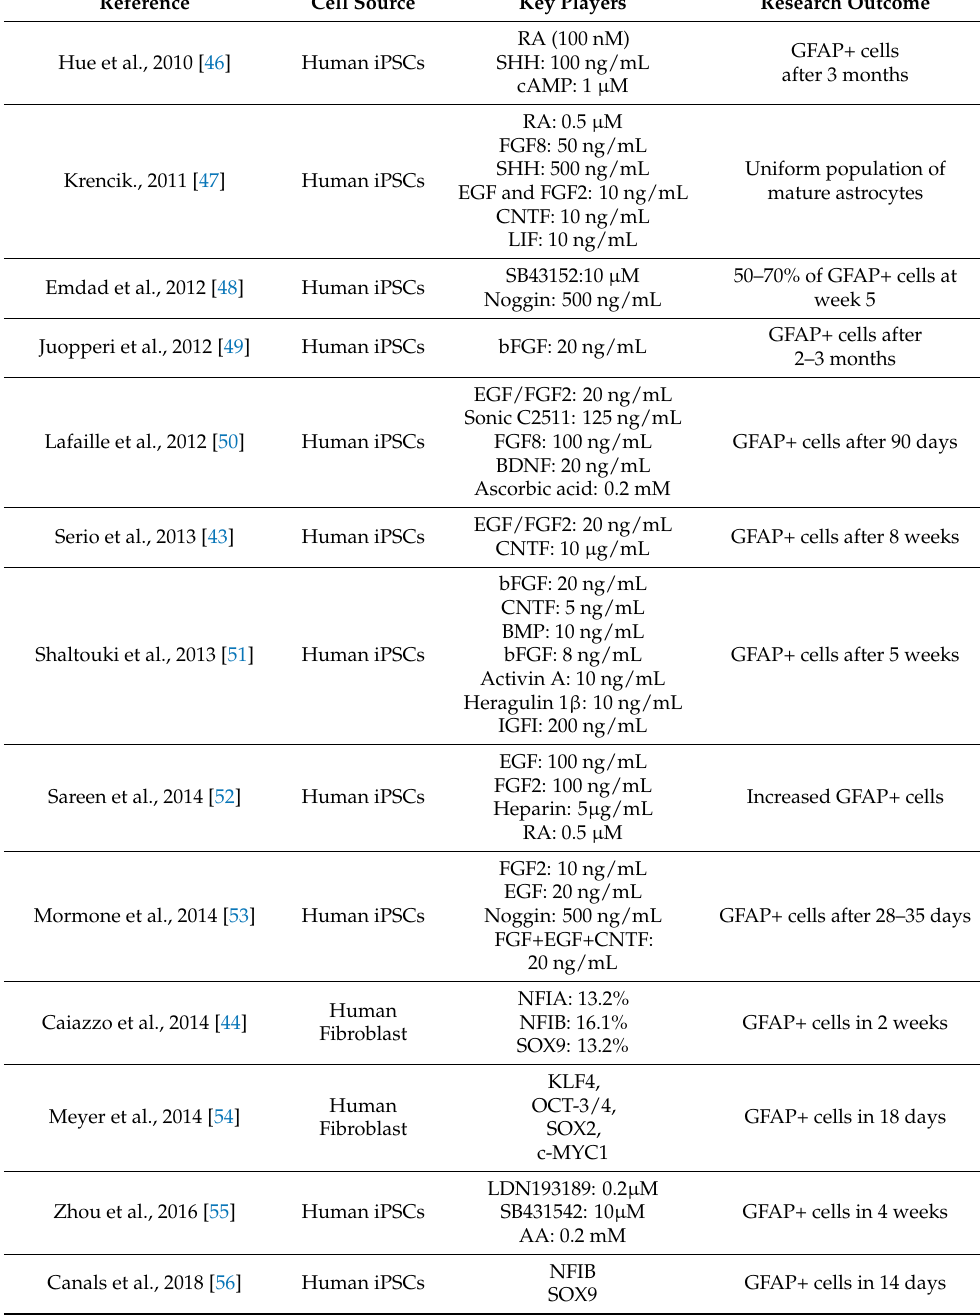
Table 1. Protocols for the differentiation of human iPSCs into